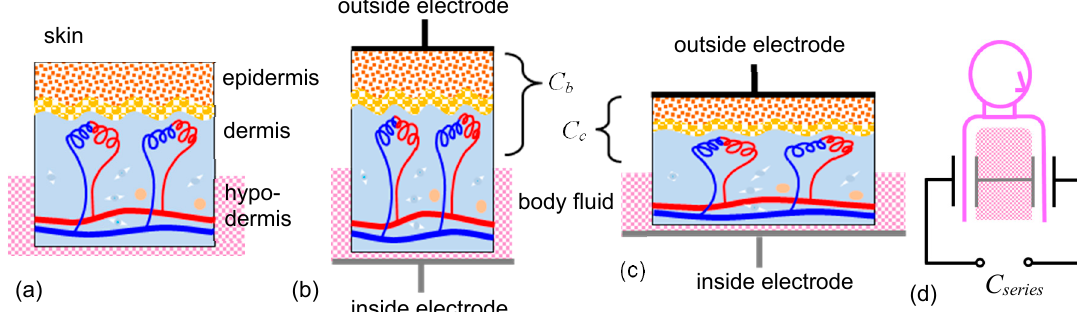
Figure 1. ( a ) Skin structure. Model of the electrodes constructing the capacitance across the skin under ( b ) exhalation and ( c ) inhalation conditions. ( d ) The two capacitances are considered to connect in series inside the body and are measured by the outside circuit.